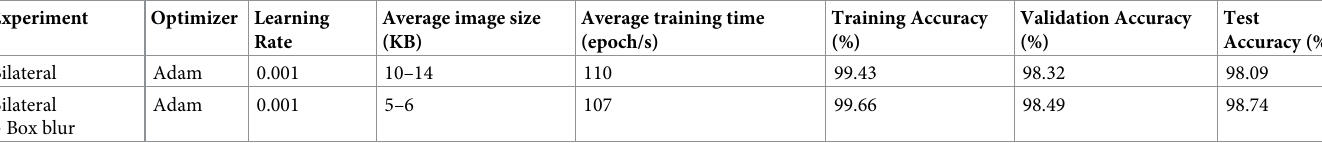
Table 15. Comparison among Bilateral and Bilateral + Box blur filter based on accuracy, average image size and average training time.